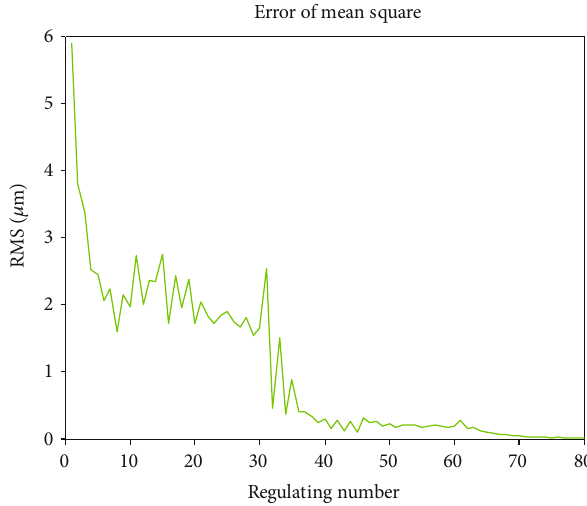
Figure 14: Root mean square (RMS) based on 25